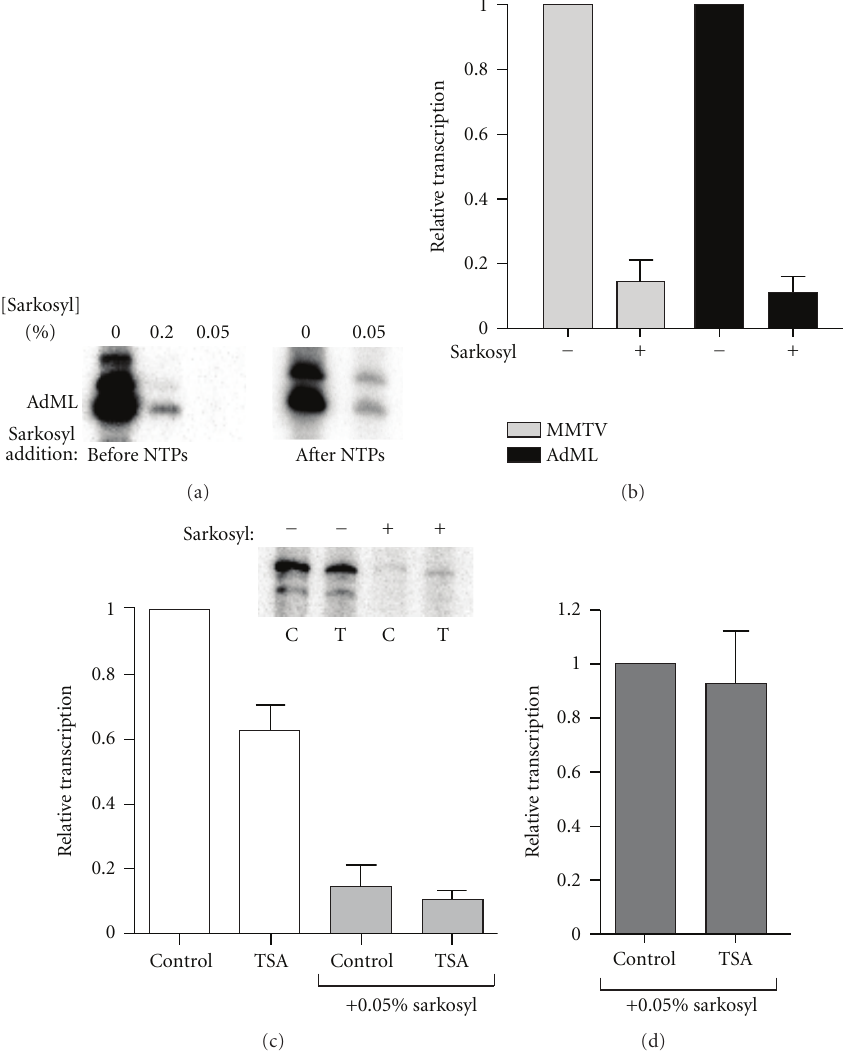
Figure 5: HDAC inhibition by TSA impairs reinitiation of transcription from the MMTV promoter in vitro. (a) In vitro transcription was carried out with the AdML template. Nuclear extracts were mixed with the template, and PIC assembly was allowed to proceed for 1h. Sarkosyl was added either 2 minutes before or 10 seconds after NTP addition. Transcription was allowed to proceed for 1h. (b) In vitro transcription was carried out in the presence or absence of sarkosyl (0.05%) added after NTP addition using either the MMTV or AdML templates as described in Section 2. Transcription levels in the presence of sarkosyl are expressed relative to levels of transcription measured in the absence of sarkosyl. (c, d) Transcription of the MMTV template was carried out using extracts from either control or TSA-treated cells in the presence or absence of sarkosyl (0.05%). In (c), transcription levels are expressed relative to those measured in control extracts in the absence of sarkosyl. In (d), transcription levels measured in extracts from TSA-treated cells are expressed relative to those measured in control extracts, both in the presence of sarkosyl. The results shown were obtained from three independent experiments, and error bars represent